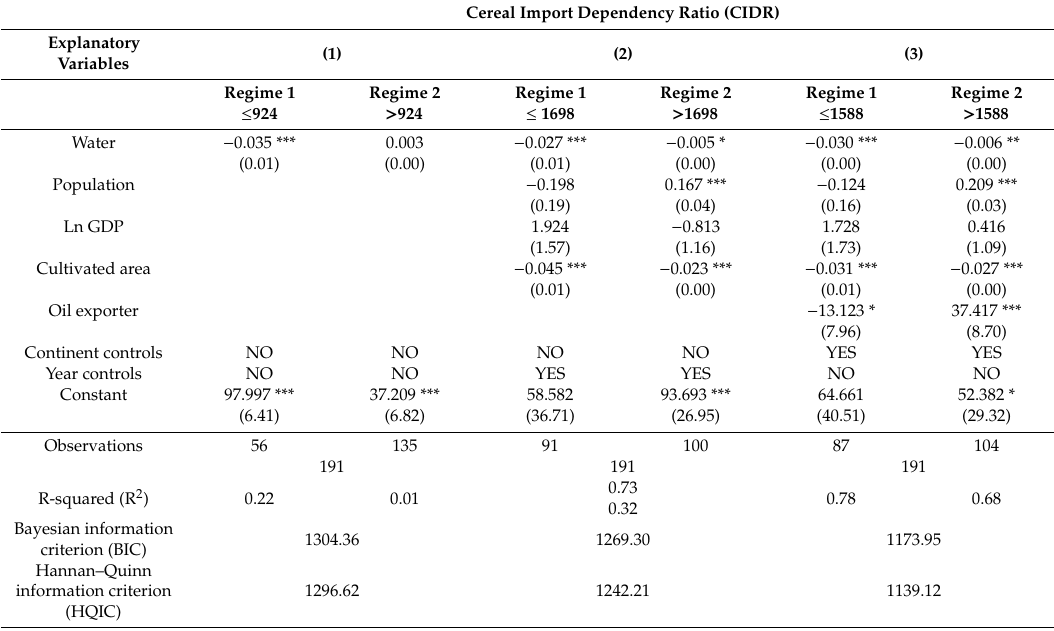
Table 3. Threshold estimations of the relationship between a country’s total renewable water resources per capita and the cereal import dependency ratio